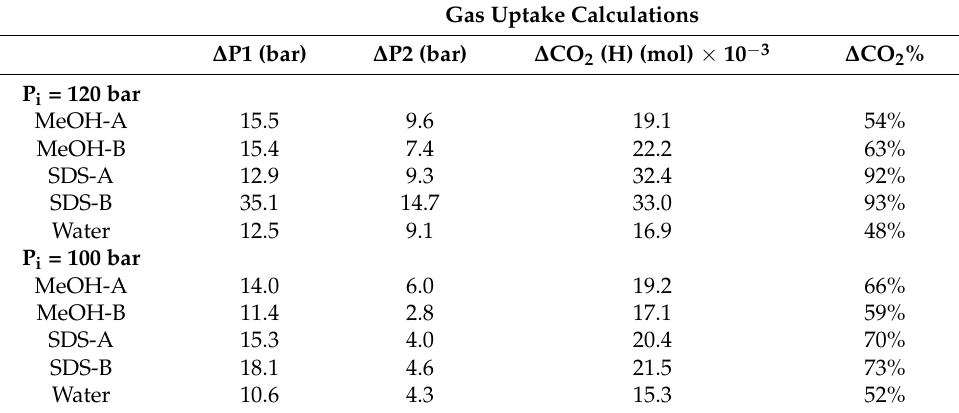
Table 7. Provide CO 2 gas uptake in hydrate calculations in the presence of MeOH (1 wt%, 5 w%) and SDS (50 ppm, 100 ppm) and pure water. ∆ P1 is total pressure drops at T = − 2 ◦ C, ∆ P2 is total pressure drop at T = 1 ◦ C. Induction time measured at T = 1 ◦ C, ∆ CO 2 (H) = CO 2 moles in hydrate, ∆ CO 2 % = capture